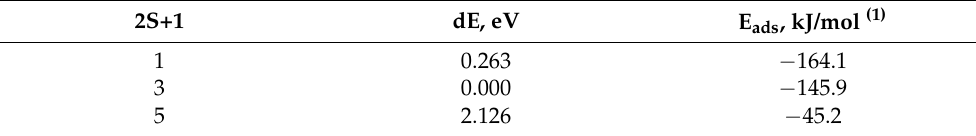
Table 2. Relative energies of Pd 4 *C 6 H 6 and the energy of BZ adsorption on Pd 4 for different states.